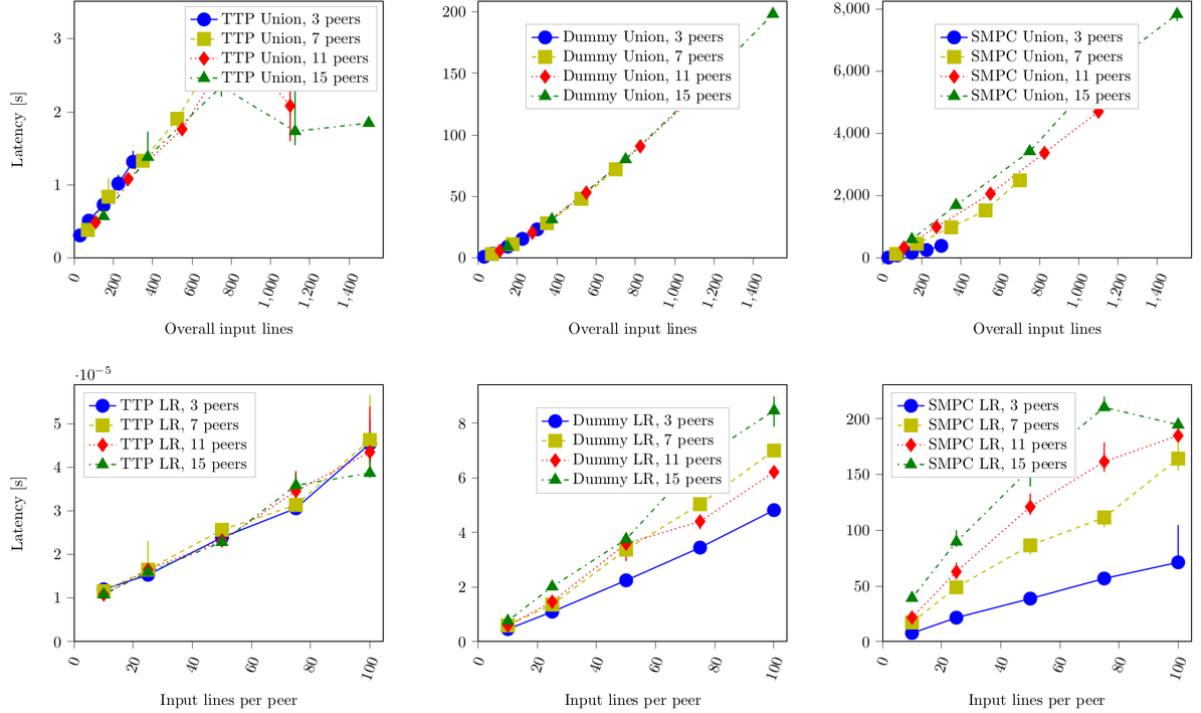
Figure 2: the spread between the different configurations in the latency diagram for the SMPC implementation of the log-rank algorithm can be exclusively explained by the fact that additional peers also add further input entries.